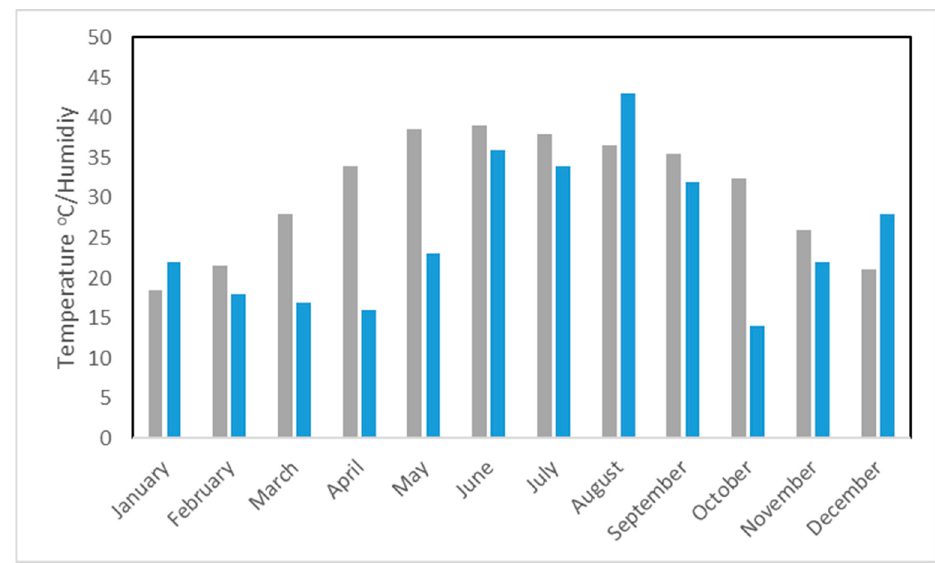
Figure 6. Weather data for the last year at the plant site [39]. Gray—temperature (°C), blue—humidity.